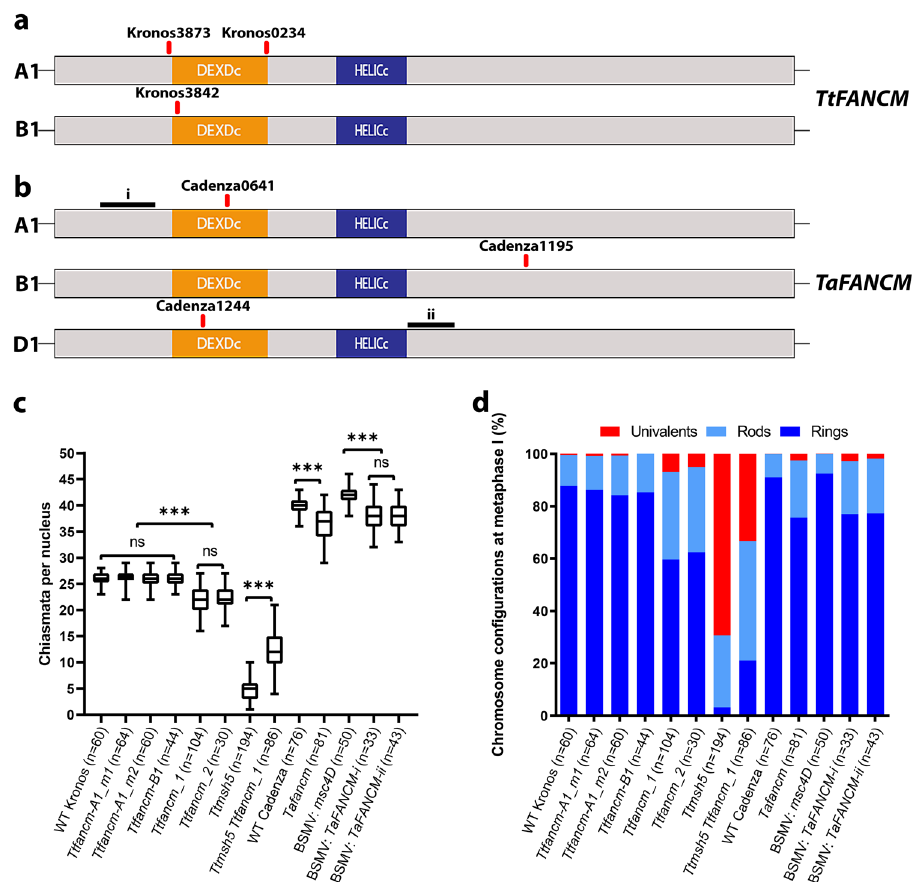
Fig. 1 FANCM promotes formation of obligate chiasma. a TtFANCM coding region for the A and B homoelogs with conserved domains shown (DEAD-like helicases superfamily (DEXDc) and helicase superfamily c-terminal (HELICc)), and TILLING mutations (red) indicated. b TaFANCM coding region for the A, B and D homoelogs with conserved domains shown (DEXDc and HELICc), and TILLING mutations (red) and VIGS target sites (black) indicated. c Box plot of chiasmata frequency per male meiocyte. Box extends from the 25th to 75th percentile, the centre line is the median value and the whiskers denote min and max values. The number of meiocytes sampled for each line is shown in brackets. n.s. = p > 0.05. *** = p < 0.001 (Pairwise Wilcoxon Rank Sum Test with Bonferroni correction). d Proportion of rings, rods and univalents per male meiocyte. The number of meiocytes sampled for each line is shown in brackets. Source data are provided as a Source Data fi